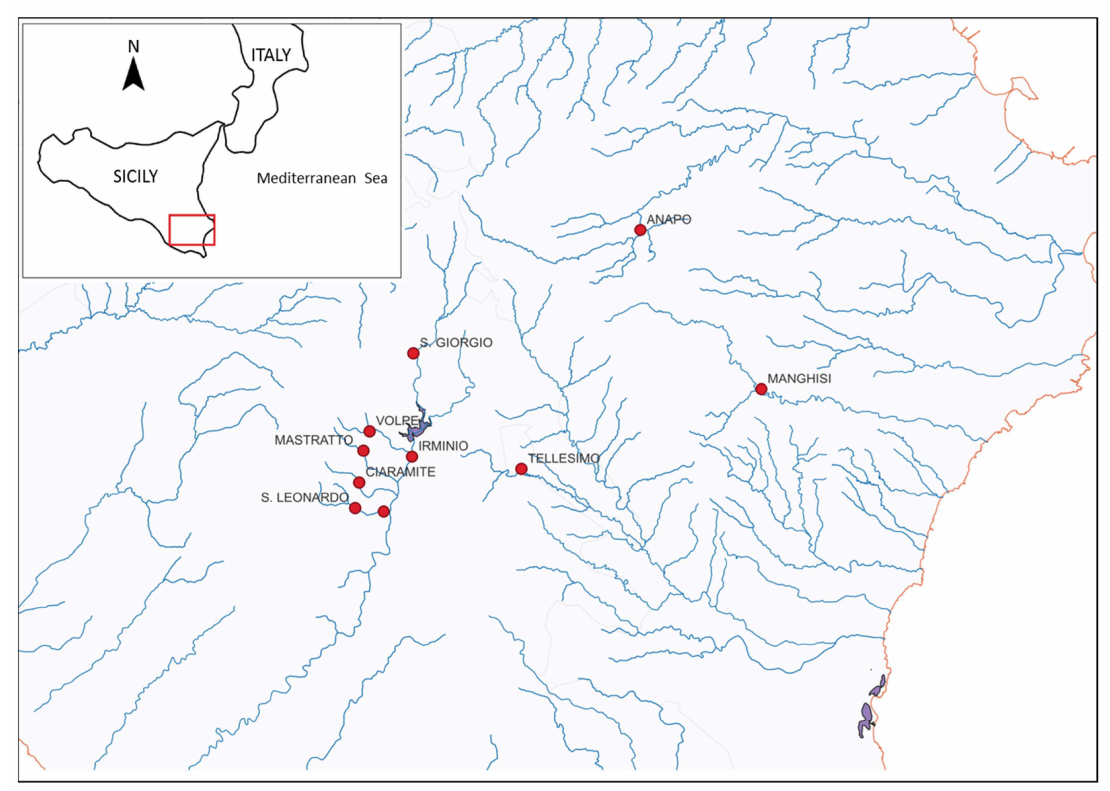
Figure 1. Geographical location of Sicilian trout samples